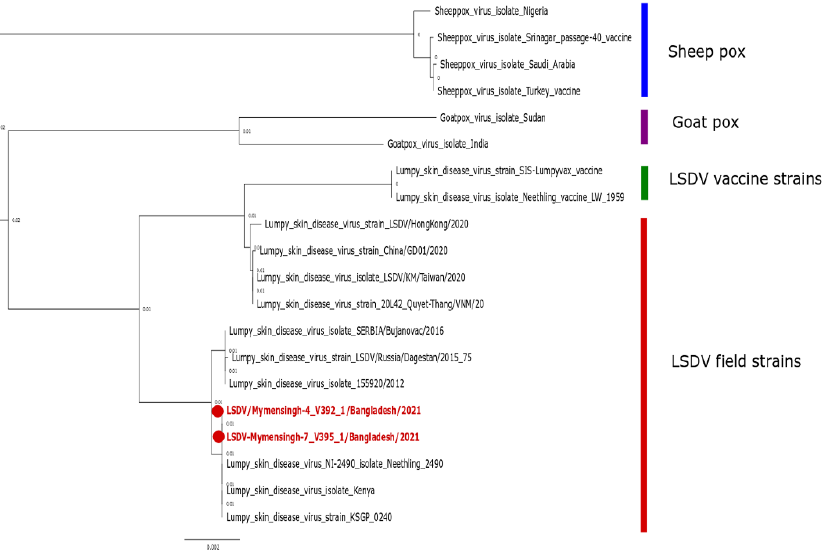
Figure 6. Phylogenetic analysis of Bangladeshi LSDV isolated from affected cattle. Neighbor-joining tree based on complete genome (150,773 bp) of capripoxviruses. LSDV from Bangladesh are highlighted by the red dots and taxon and clustered with older field strains of LSDV. Trees were generated after the selection of the best-fitted model using the MAFT software’s web version and viewed in Figtree